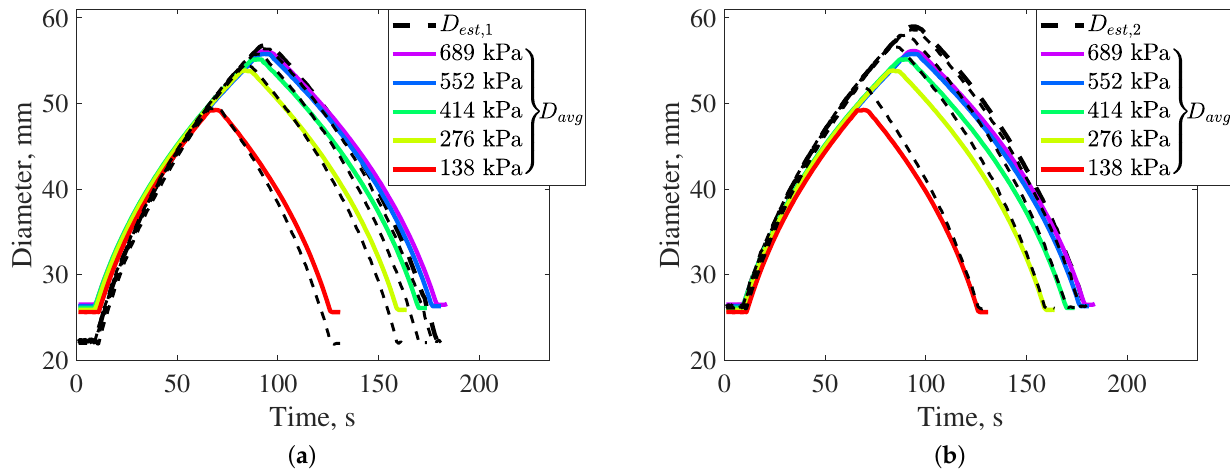
Figure 16. Comparison of the average measured diameter values, D avg , against estimated diameters, D est : ( a ) D est ,1 (Initial geometry: D 0 = 22.2 mm, θ 0 = 72.27 deg.). ( b ) D est ,2 (Initial geometry: D 0 = 26.0 mm, θ 0 = 69.04